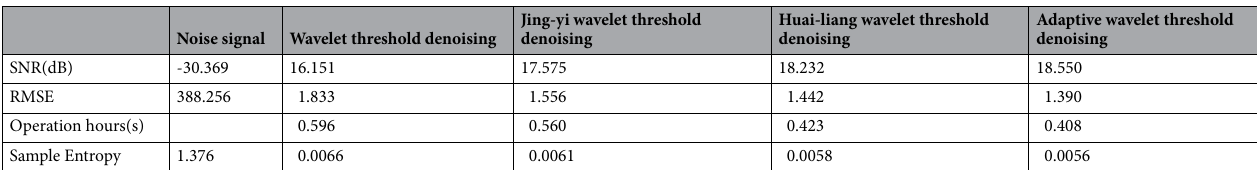
Table 4. Quantitative evaluation of the denoising effects of analog signals based on different methods.